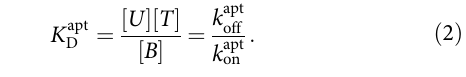
Þ , which re fl ects the The effective dissociation constant ð K eff D effective binding af fi nity of the overall equilibrium, can be